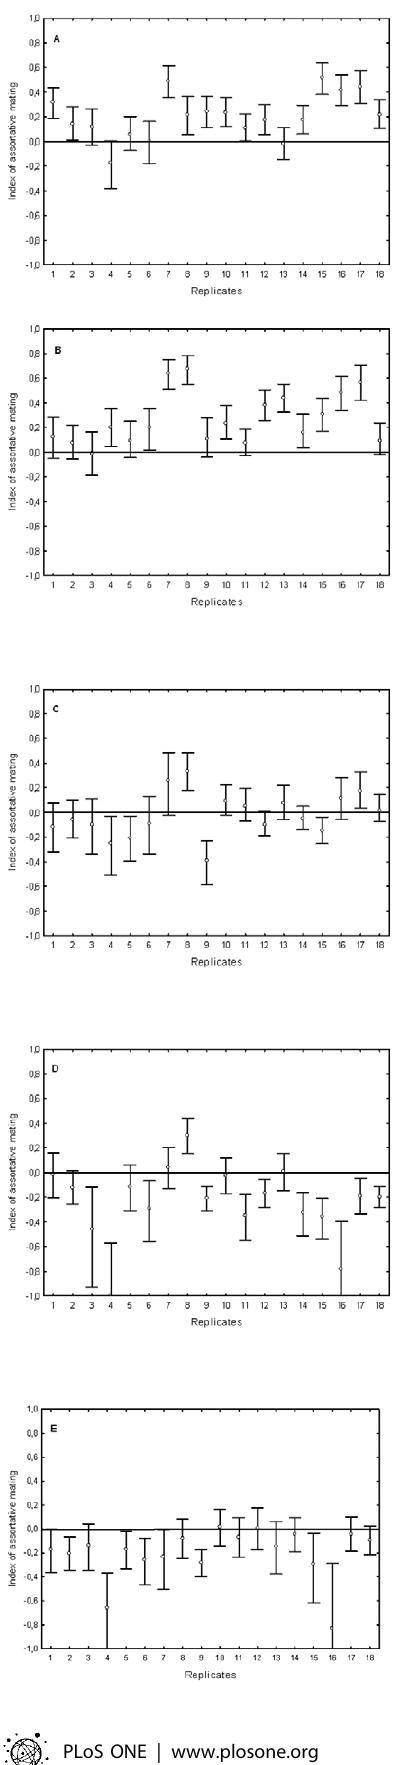
Figure 2. Mean index of assortative mating. Mean ( 6 95% confidence interval) index of assortative mating for all 18 replicates. Replicates 1–9 were run on BE beans, and replicates 10–18 on mung beans. a) Generation 1, b) generations 2, c) generation 3, d) generation 4, e) generation 8.